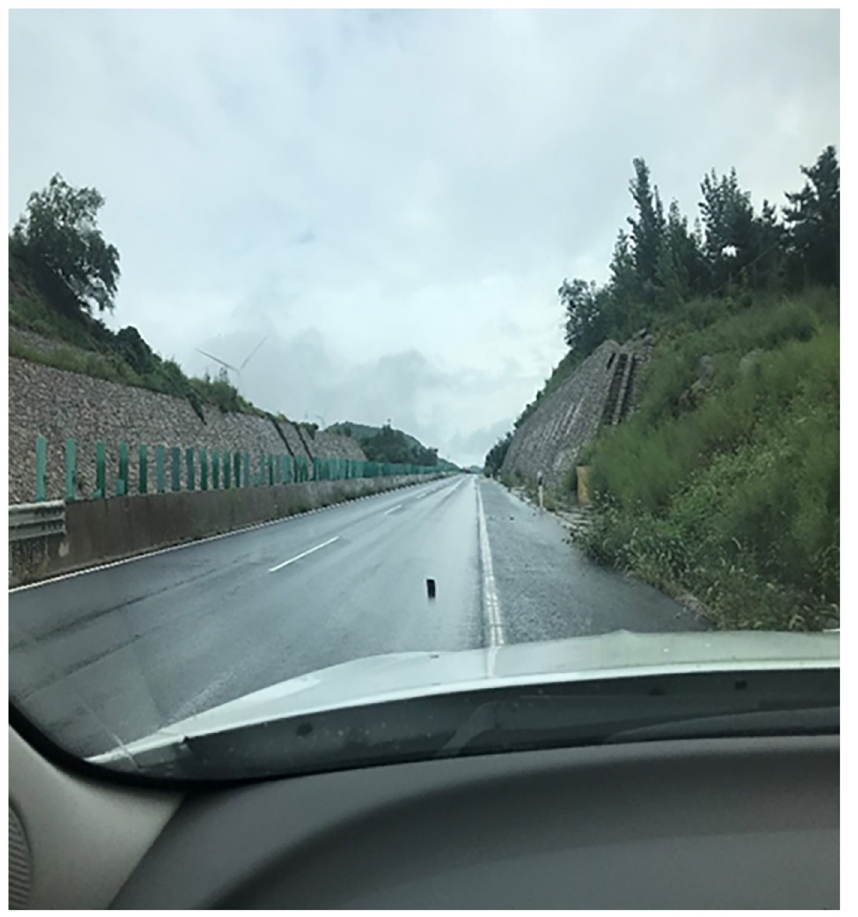
Fig 2. The road experimental